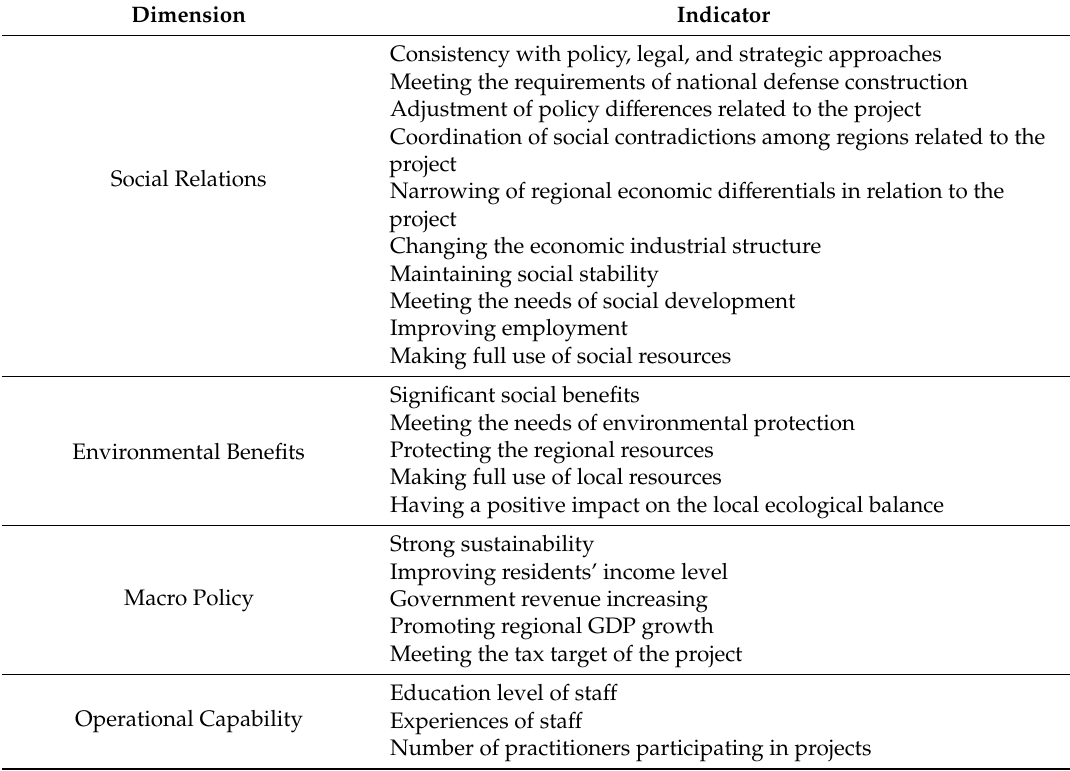
Table 10. Final indicator